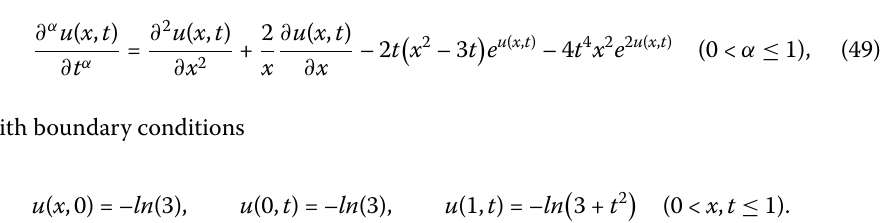
For α = 1, the exact solution of (48) is u ( x , t ) = 3 M = 5 by the LWAM. The approximate solution for N = 6 is u LWAM = plotted in Fig. 2 the absolute errors for various values of N = 1,2,...,6. One can check that by increasing the values of N absolute errors are decreasing. Table 3 shows the comparison of absolute errors for different values of α and the method introduced in [33, 36]. Table 4 shows the comparison of absolute errors for different values of k and M . Also it shows that by increasing of k and M absolute errors are